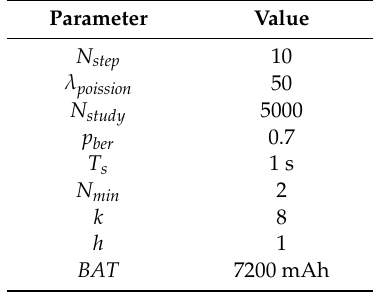
Table 8. Configuration parameters for the experimental